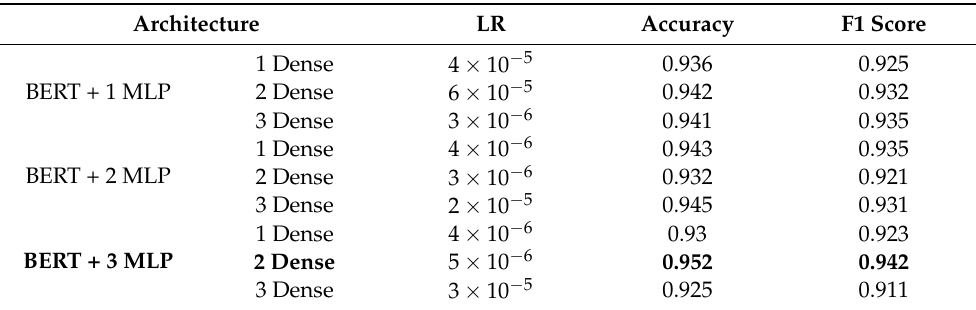
Table 5. Comparing BERT + MLP Classifier results. (Bold text indicates the model parameters achieving the highest accuracy.)